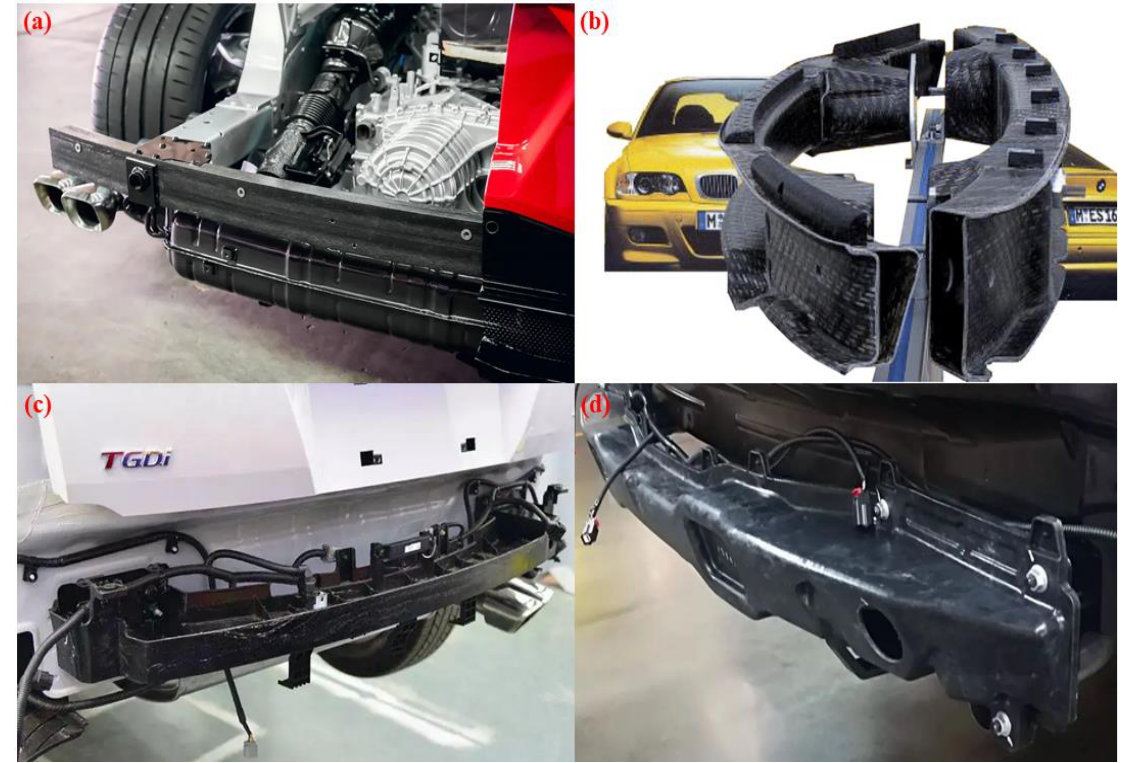
Figure 3. Application of composites in bumper beam. ( a ) Corvette C8, ( b ) BMW M3, ( c ) Hyundai TUCSON, ( d ) GEELY Emgrand X7 Sport.